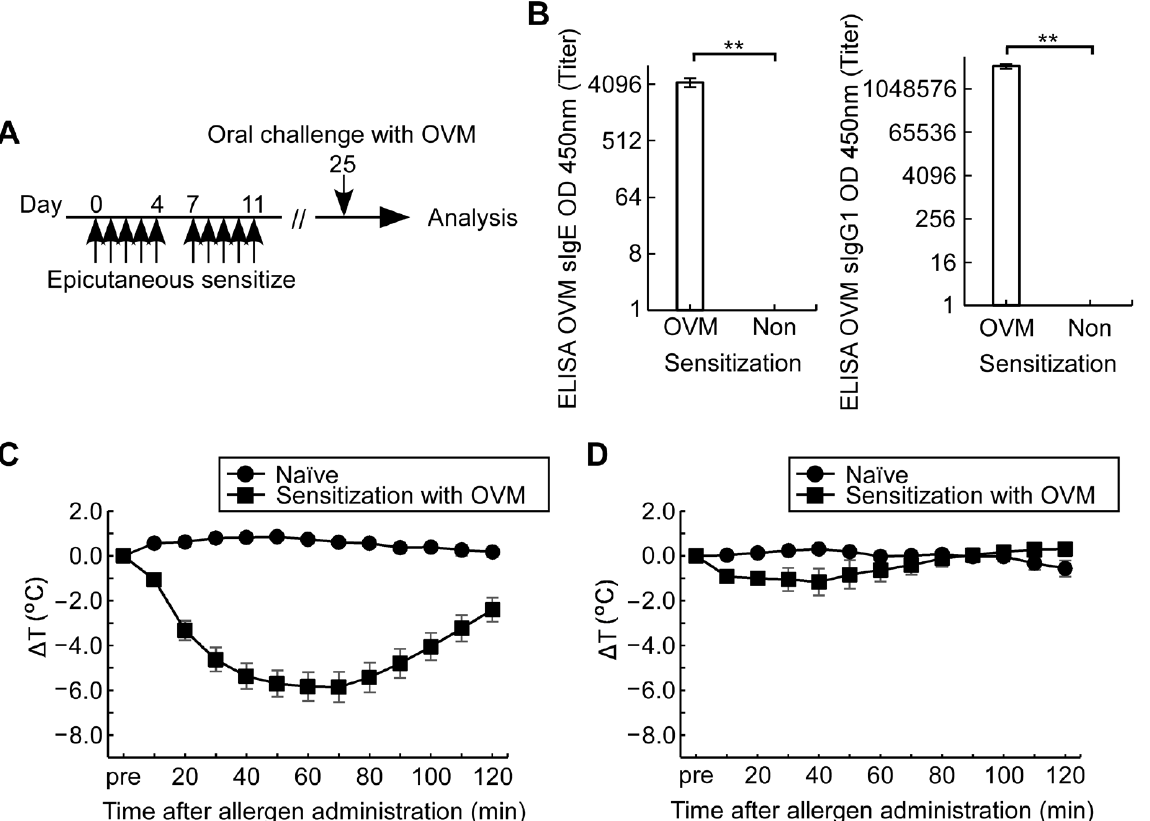
Figure 1. Experimental design. For epicutaneous sensitization, the shaved back skin of BALB/c female mice ( n = 5–10/group) was treated with 4% SDS and 1 mg OVM, without adjuvant, five times a week in the first 2 weeks. On day 25, mice were orally challenged with OVM and allergic reactions were monitored. ( A ) Experimental protocol; ( B ) Serum levels of OVM sIgE and sIgG1 on day 11; ( C ) ∆ T after intraperitoneal challenge with 1 mg OVM; ( D ) ∆ T after oral challenge with 20 mg OVM. Data are mean ± SEMs. ** p < 0.01.